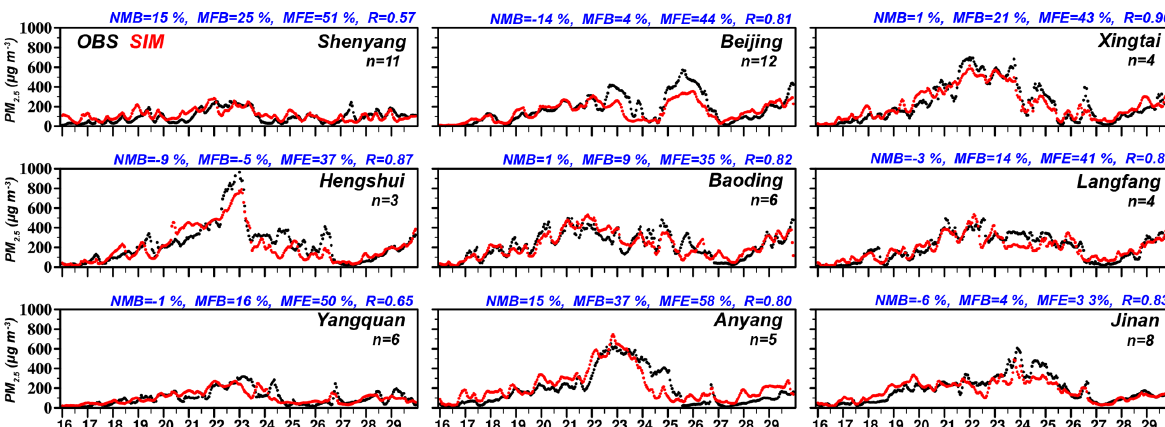
Figure 4. Time series of the observed (black dots) and simulated (red dots) hourly PM 2 . 5 concentrations (µgm − 3 ) in the nine cities (Shengyang, Beijing, Xingtai, Hengshui, Baoding, Langfang, Yangquan, Anyang, and Jinan) from 16 to 29 December 2015. The “ n ” in each panel represents the number of observation sites in each city. Beijing time is used for these hourly time series.